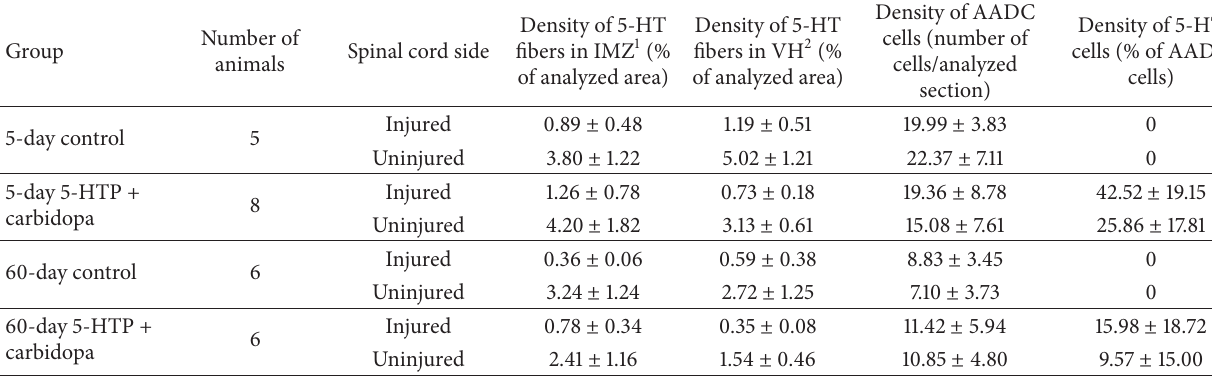
Table 1: Summary of the results from the different animal